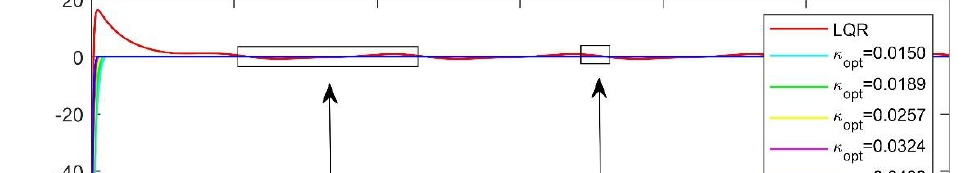
Figure 5. The step tracking speed error curve of the electric tail reduction system.